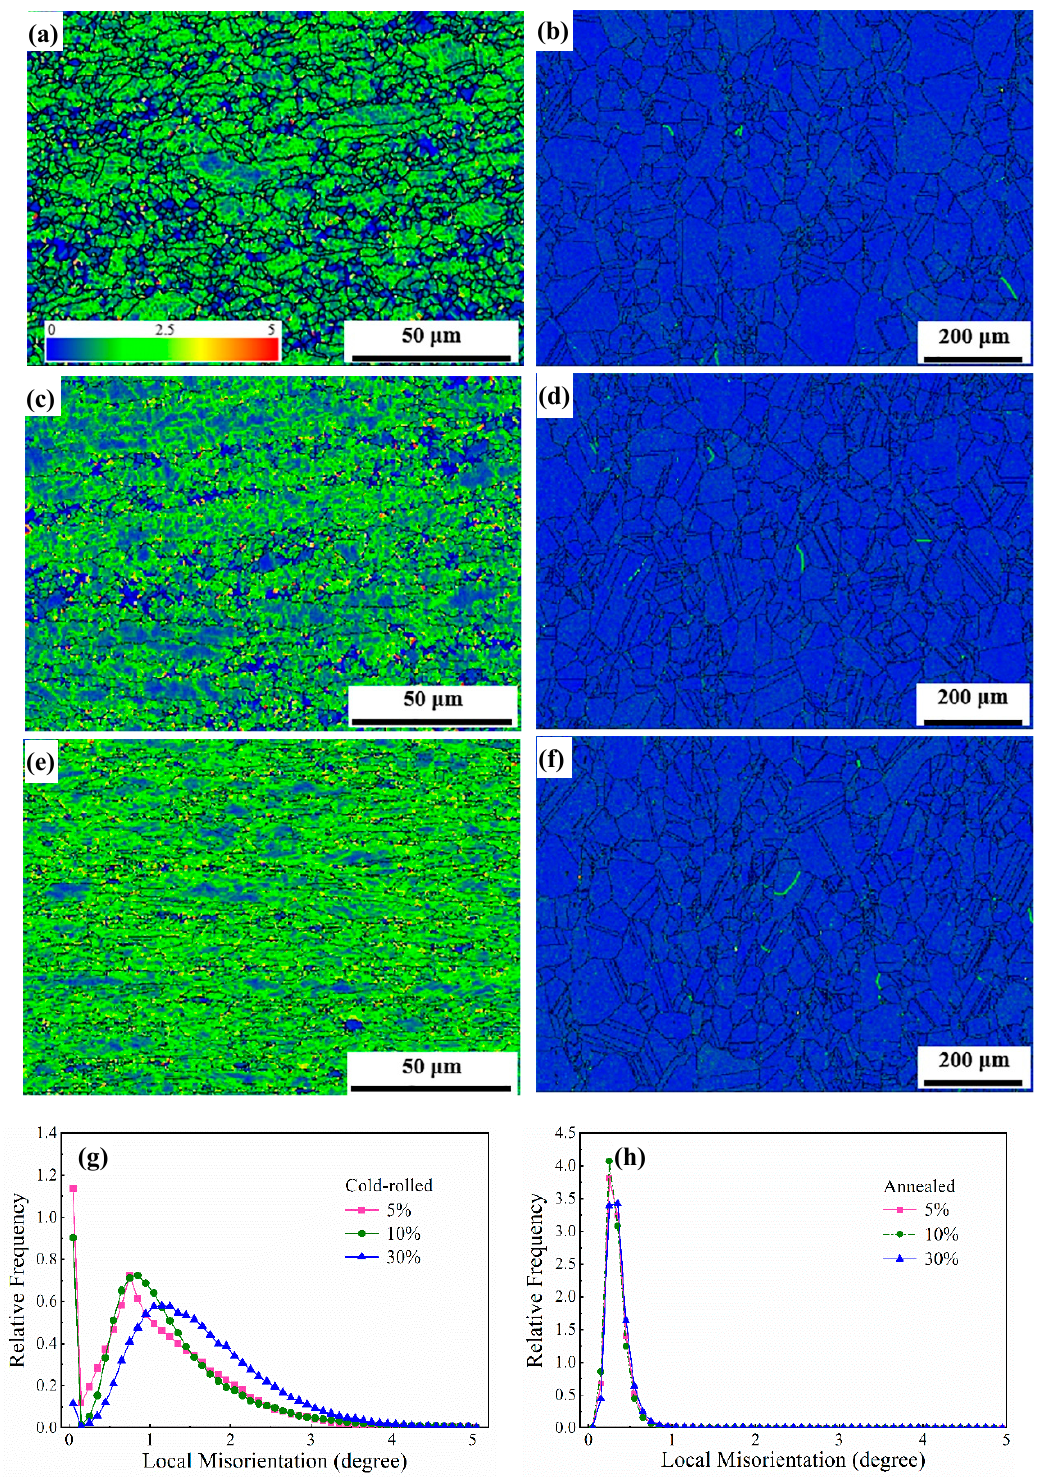
Figure 5. Local misorientation distributions of the AFA steel reduced by ( a ) 5%, ( c ) 10% and ( e ) 30% and then annealed at 1150 °C for 30 min after cold rolling ( b , d , f ). ( g ) and ( h ) represent curves of local misorientation distributions, misorientation distributions, respectively.